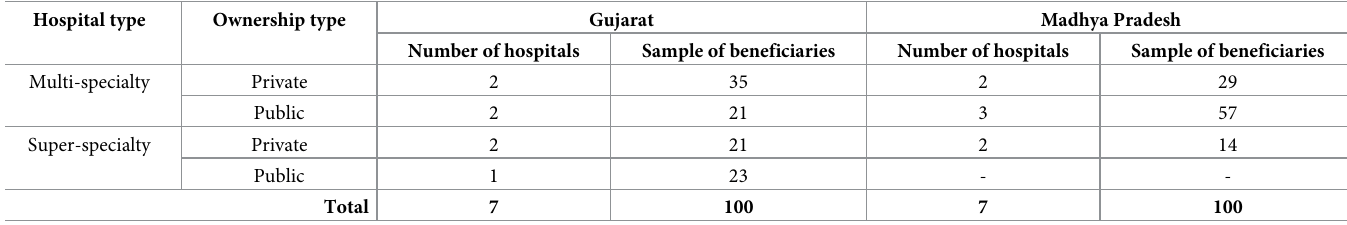
Table 1. Study hospitals and surveyed beneficiaries, by